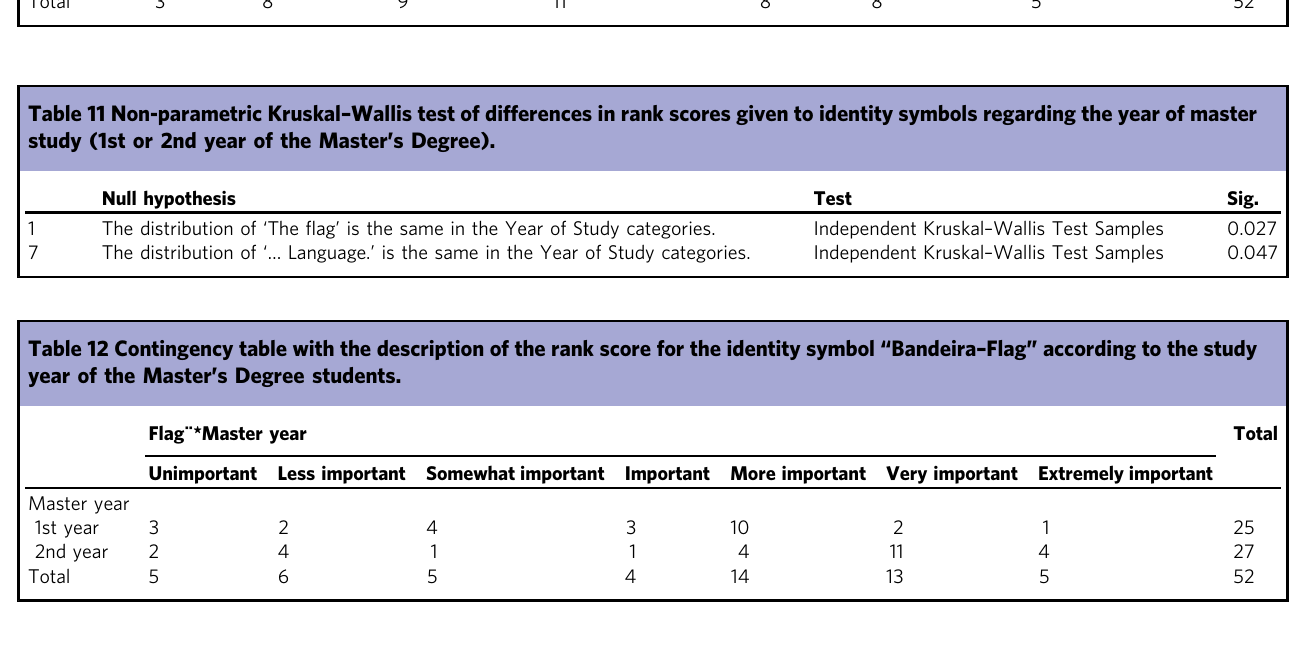
Table 13 Contingency table with the description of the rank score for the identity symbol “ Língua – Language ” according to the study year of the Master ’ s Degree students.